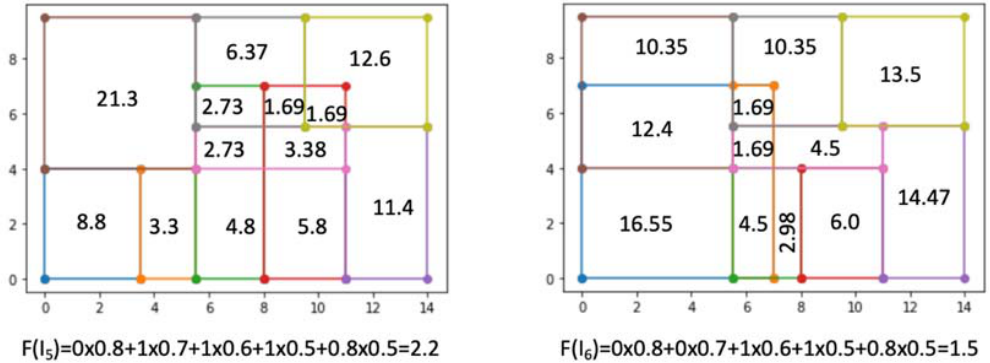
Figure 9. Two example floor plans I 5 and I 6 where only REQ2 had a different evaluation value.